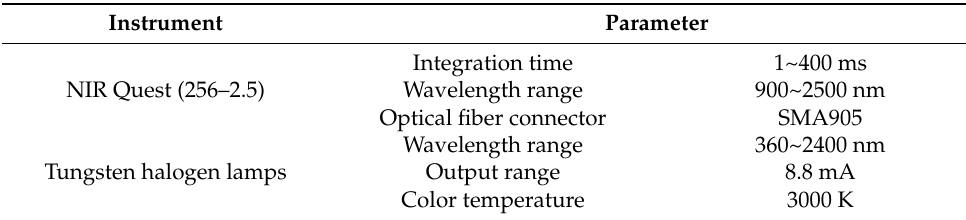
Table 1. Instrument parameter